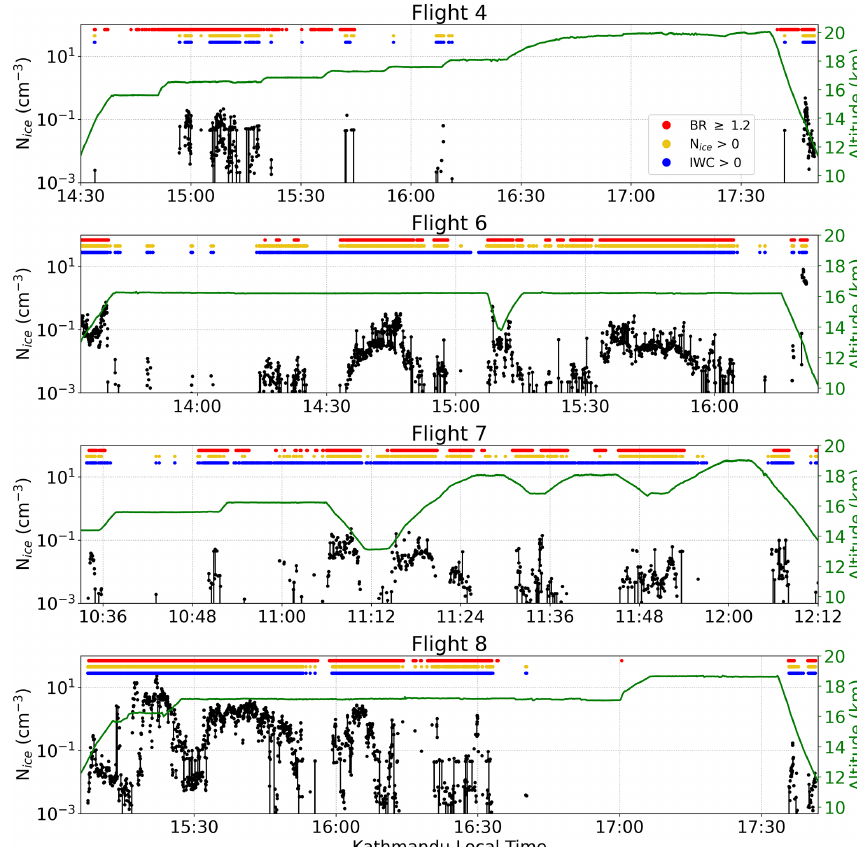
Figure 2. Time series of ice particle number concentration ( N ice , black) measured by NIXE-CAPS for F4, F6, F7, and F8. No clouds were sampled on F2 or F3. Shown in colors at the top of each panel are cloud flags derived from MAS backscatter ratio (BR ≥ 1 . 2, red), N ice > 0cm − 3 (yellow), and ice water content (IWC > 0gkg − 1 , blue). Clear sky is inversely defined as regions where BR < 1 . 2 or N ice = 0cm − 3 . The IWC is defined as the difference between FISH and FLASH and is thus an unreliable flag for clear sky in an intercomparison study like this where we are specifically interested in the small deviations in vapor measurements between these two instruments. Flight altitude is shown in green.